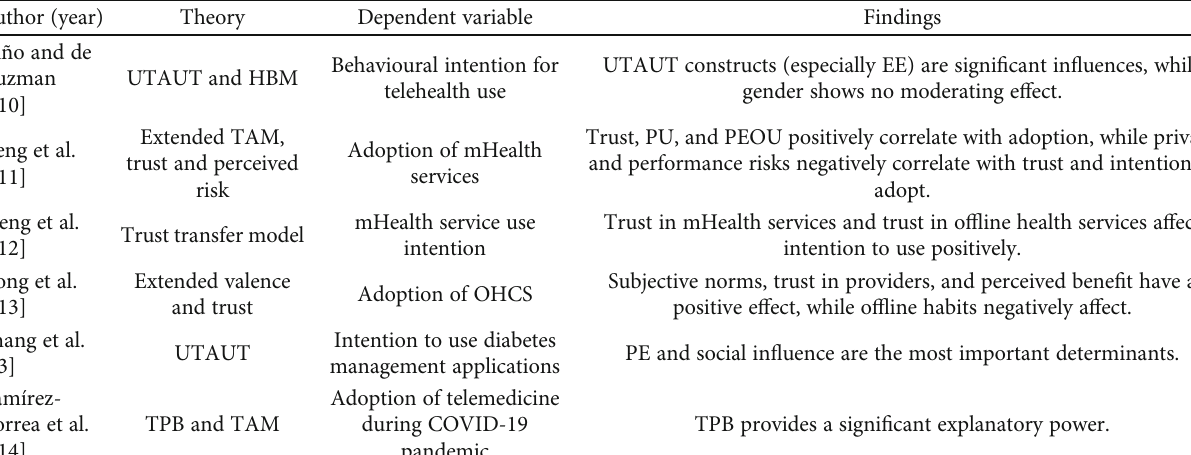
Table 1: Summary of studies with mHealth adoption